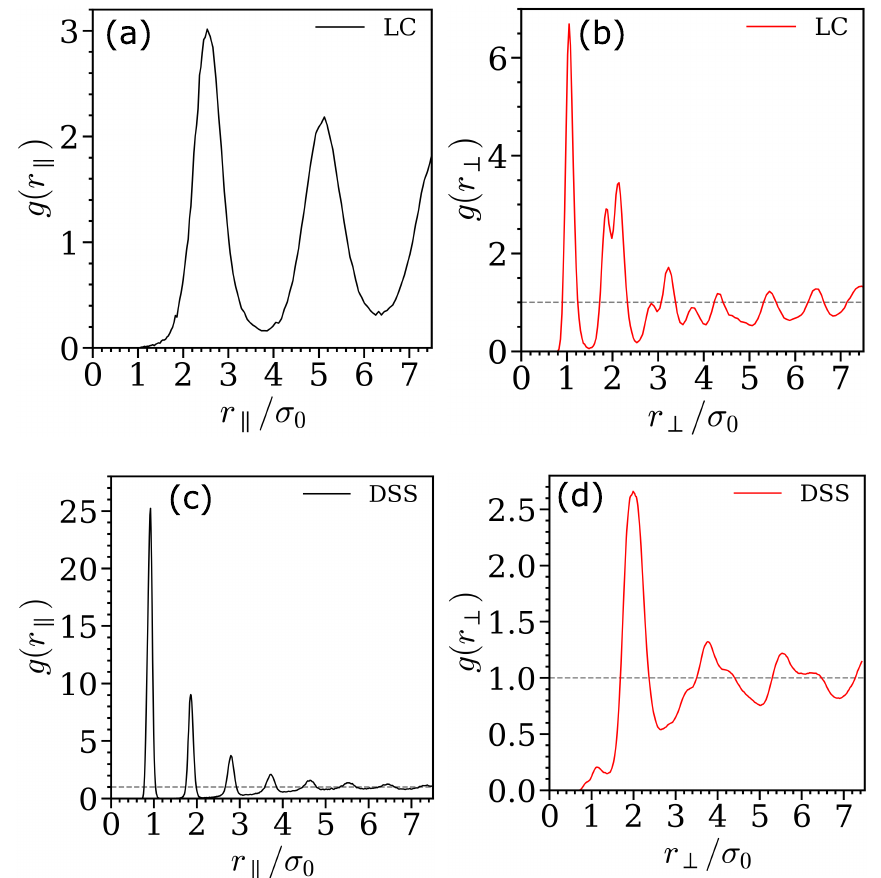
Figure 6. Pair correlation functions as a function of distance for the LC-DSS mixture at the density, ρ ∗ = 0.58: panel ( a ): Longitudinal pair correlation function for the LCs, g ( r (cid:107) ) , as a function of distance; panel ( b ): transverse pair correlation function for the LCs, g ( r ⊥ ) , as a function of distance; panel ( c , d ): projections of the pair correlation functions for distances parallel and perpendicular to the director of the DSS as a function of distance. The grey dashed line represents the value of g ( r ) equal to